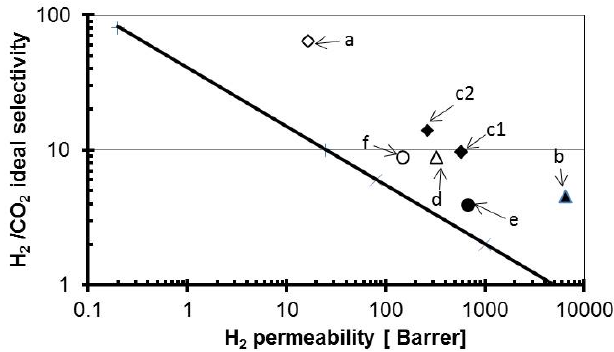
Figure 5. Robeson upper bound plot for H 2 /CO 2 for: ( a ) Low [73], ( b ) Bux [74], ( c1 ) Llosa [51], ( c2 ) Llosa [51], ( d ) Hosseini [70], ( e ) McCarthy [75], and ( f ) Campo [68].